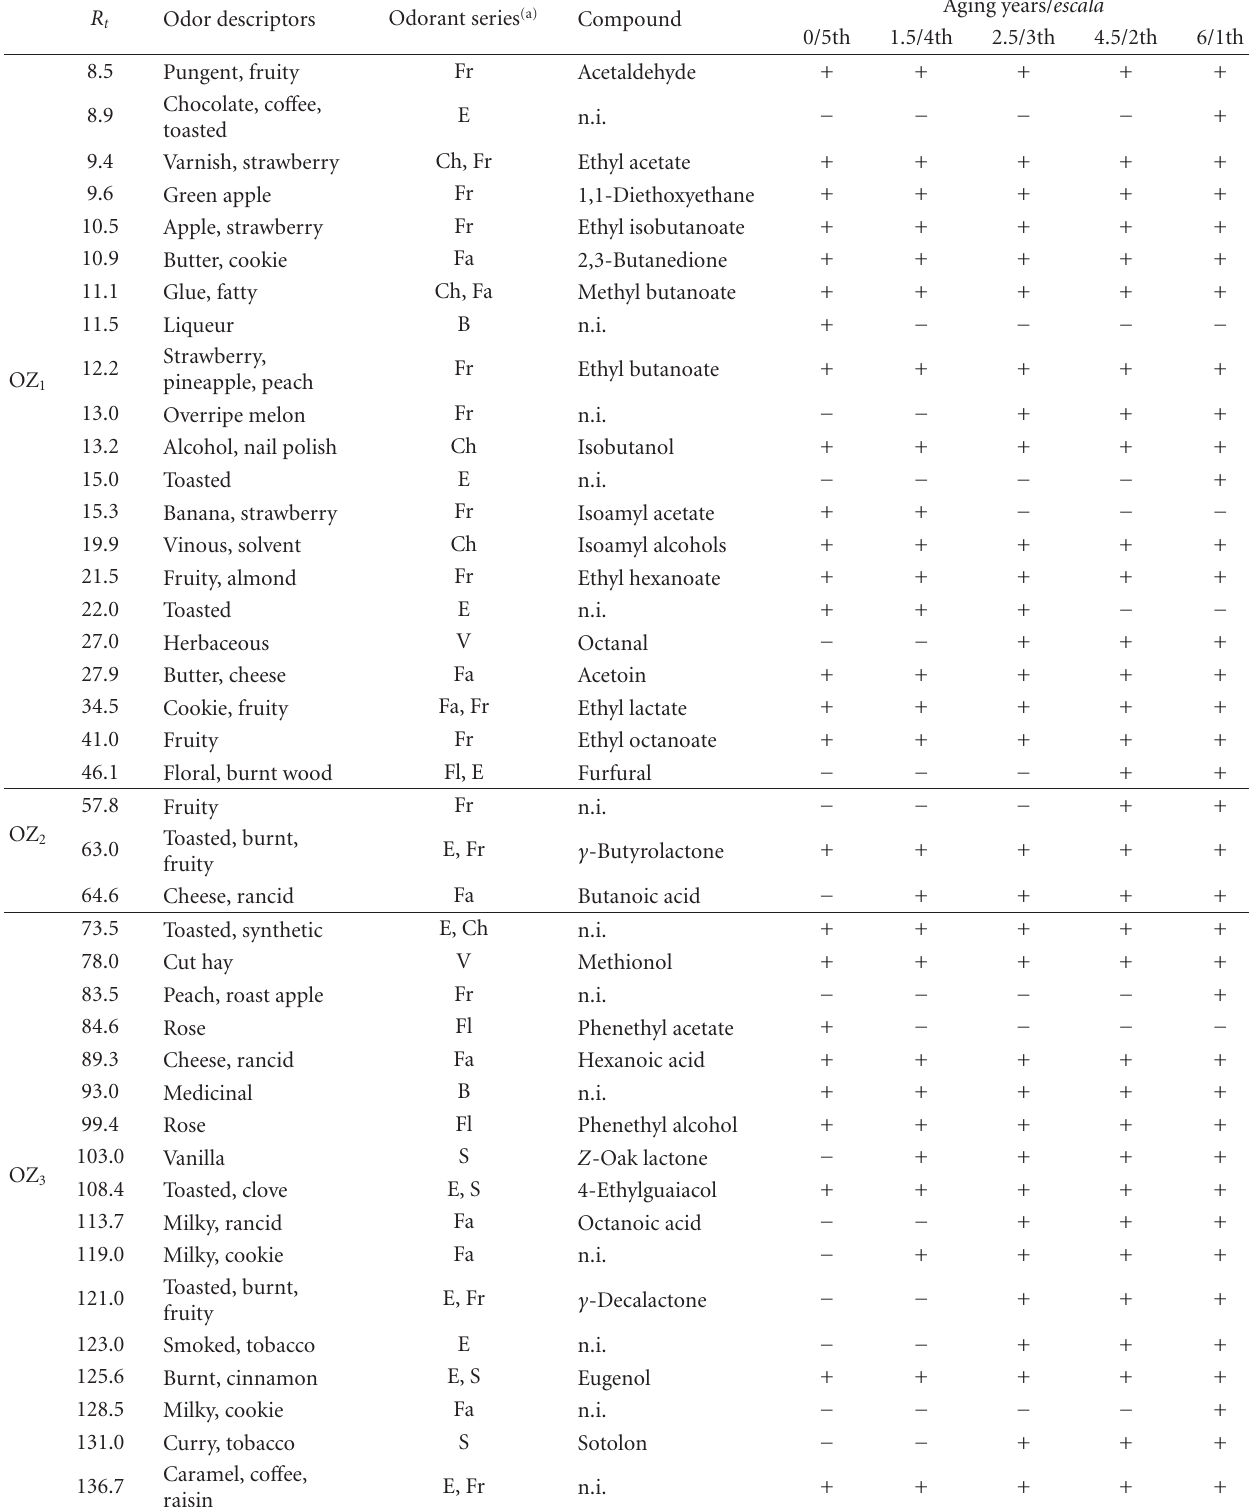
Table 1: Retention time, odor descriptors, and odorant series of the compounds detected by the sni ff ers grouped in three odorant zones (OZ). R